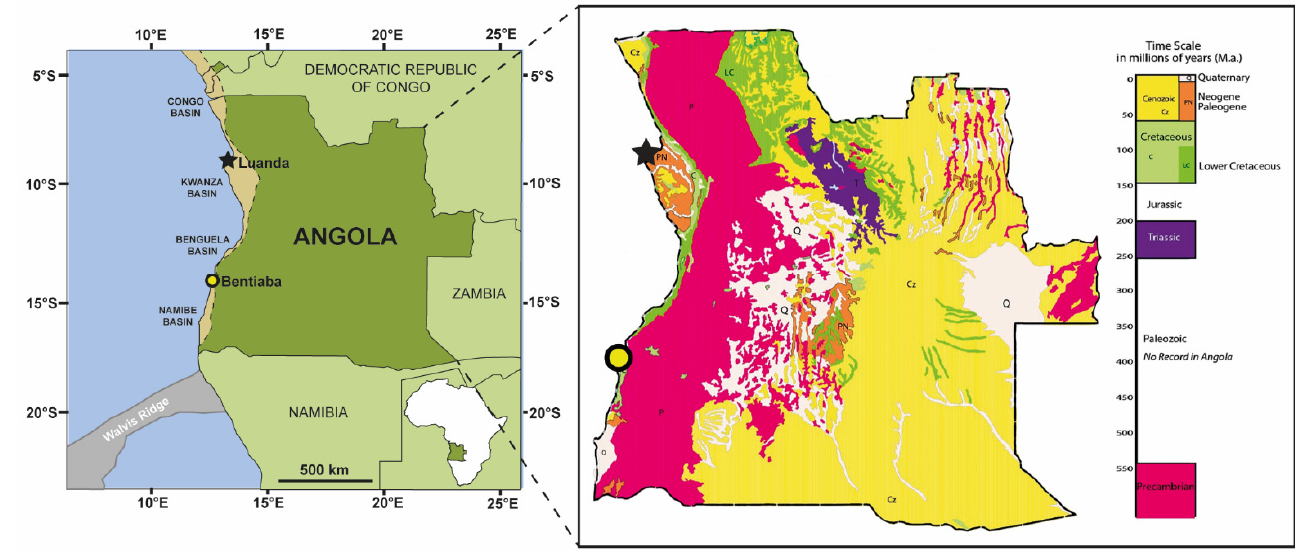
Figure 1. Location of the commune of Bentiaba with a geological map of Angola. Adapted from Strganac et al. 2014 [26] and Mateus et al. 2019 [3], according to the U. S. Geological Survey 2002 (scale: 1:30,000,000) [27].